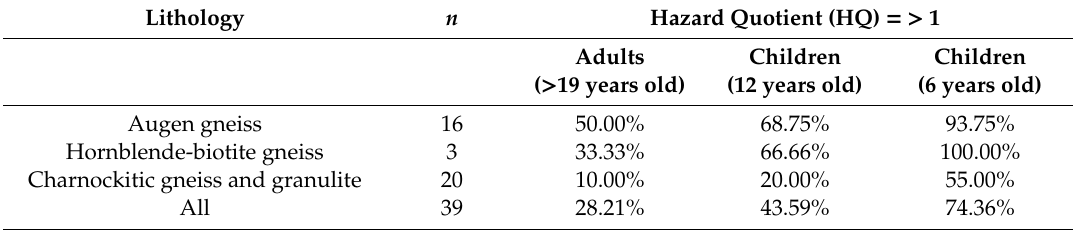
Table 4. Summary statistics for HQ values > 1 per lithology. Values are percentages of sampled water points with an HQ value > 1 for each lithology. Lithology n Hazard Quotient (HQ) = > 1 Adults Children Children ( > 19 years old) (12 years old) (6 years old) Augen gneiss 16 50.00% 68.75% 93.75% Hornblende-biotite gneiss 3 33.33% 66.66% 100.00% Charnockitic gneiss and granulite 20 10.00% 20.00% 55.00% All 39 28.21% 43.59%